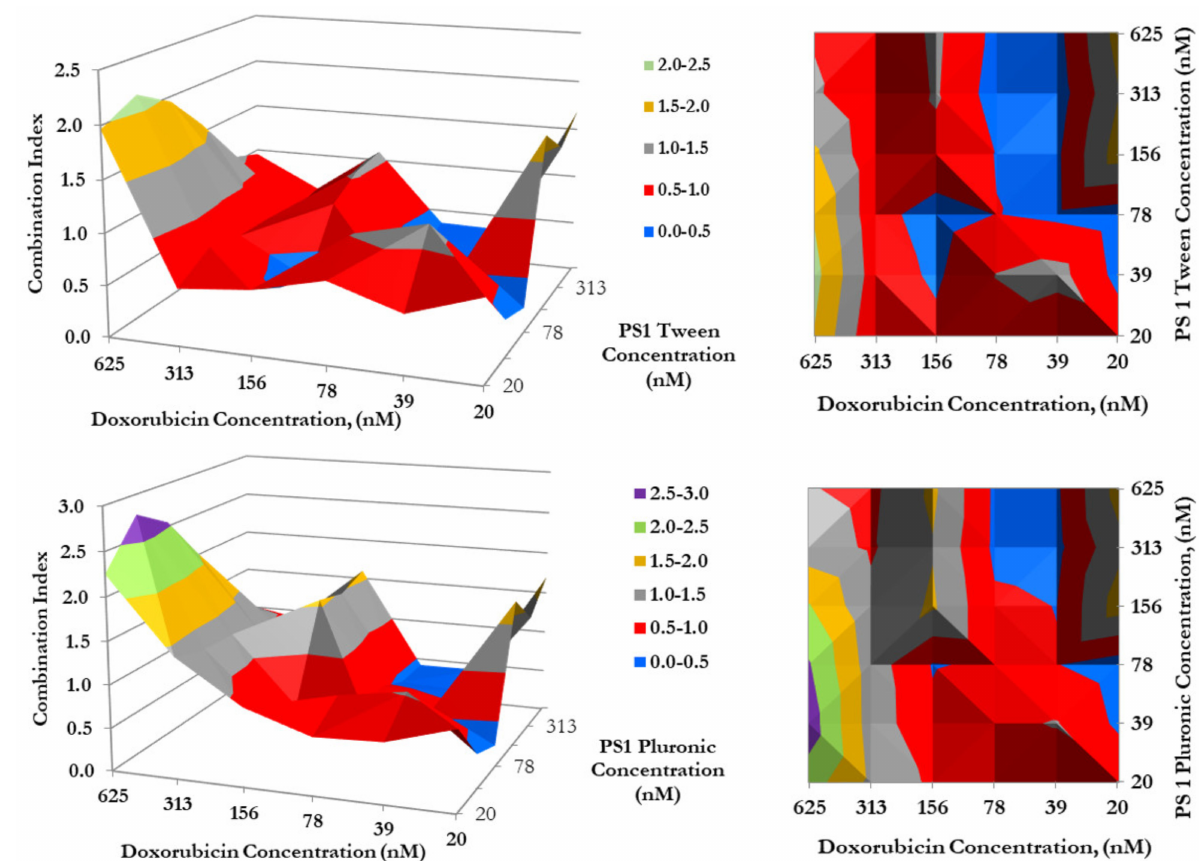
Figure 7. The synergism of doxorubicin in combination with PS 1 in either Tween or Pluronic formula- tion. Cells were plated and PS 1 was added. Cells were exposed to light (Fluence: 1.0 J/cm 2 , Fluence rate: 75 mW/cm 2 ) at 24 h post-incubation. Doxorubicin was then added at variable concentrations, and cells were incubated for 48 h, then assessed for cytotoxic effects. The combination indices (C.I.) were calculated for each point using the formula C.I. = [E PS1 + E Dox − E PS1 E Dox ]/E PS1*Dox . Peaks indicate antagonism, values near 1.0 indicate an additive effect, and valleys <1.0 indicate syner- gism. Areas indicated in red and blue denote synergetic concentrations, while grey indicates an additive